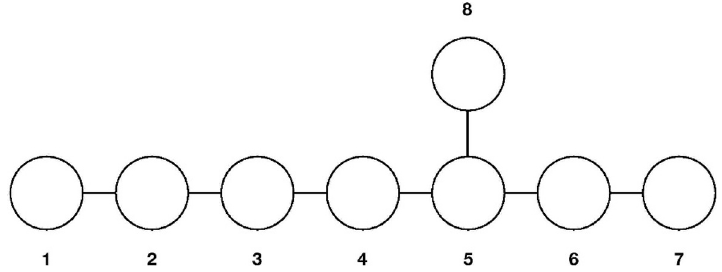
Figure 1 . Dynkin diagram for E 8